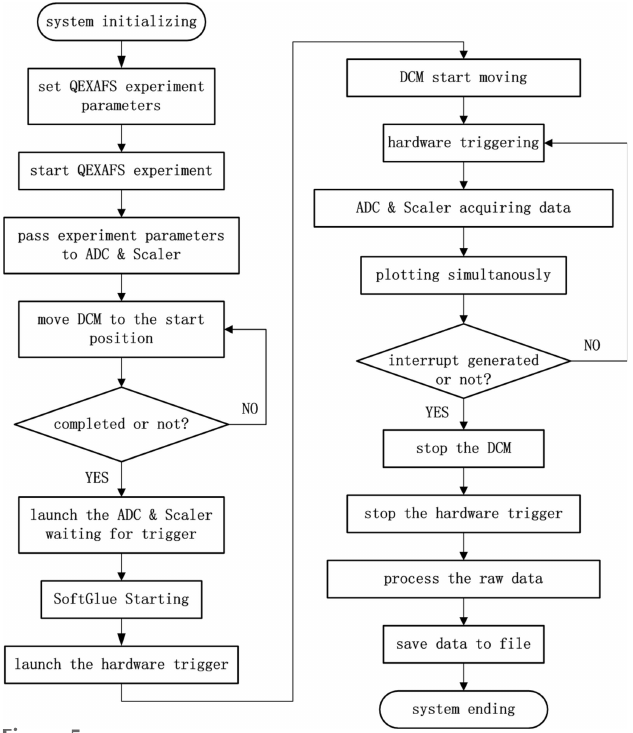
Figure 5 Software flow pattern of the QEXAFS